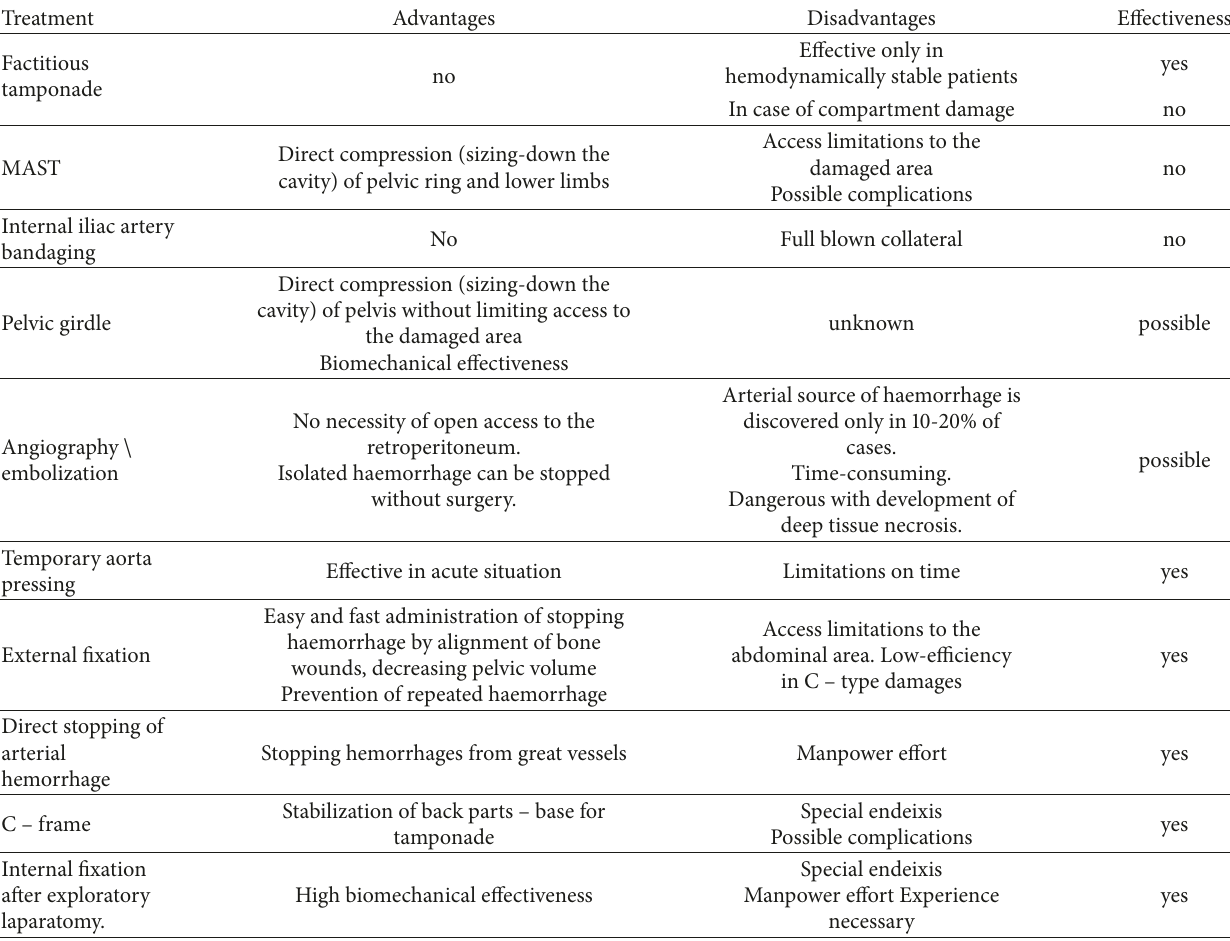
Table 1: Treatment options for patients with pelvic and hemodynamic